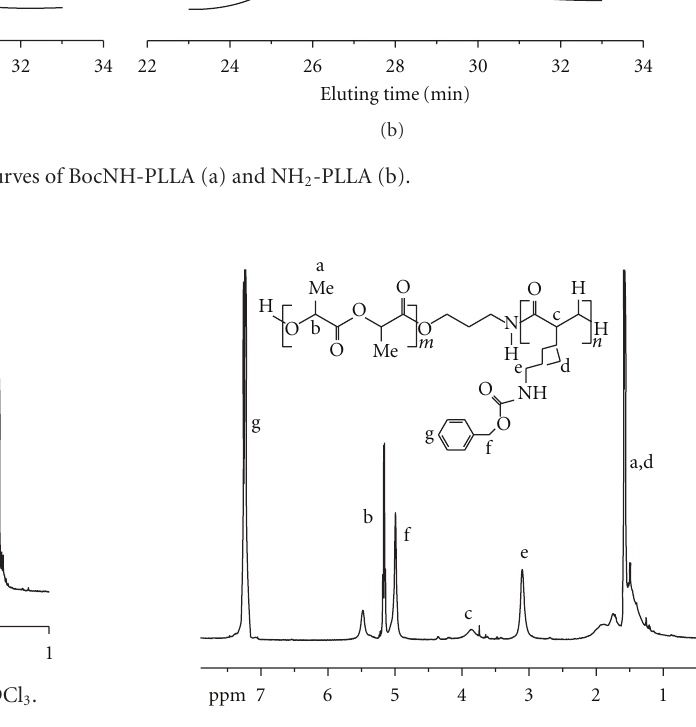
Figure 7: 1 H NMR spectra of the block copolymer of PLLA- b - PZLys.